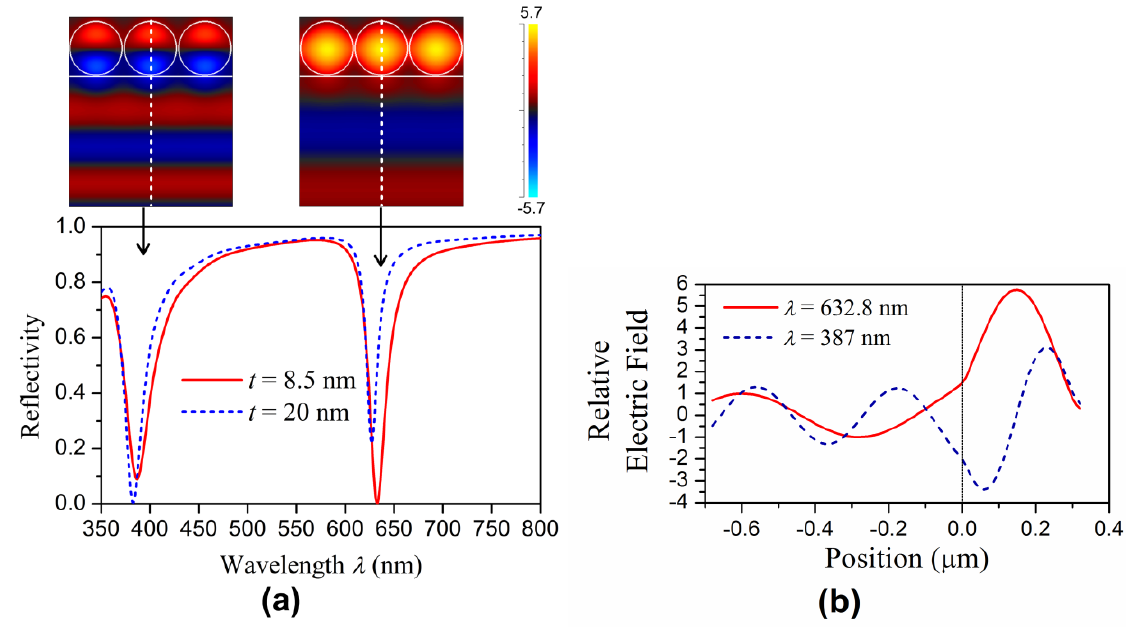
Figure 2. (a) Reflection spectrum for the normal incident light. The two insets show the relative electric field distributions for the two spectral dips, respectively. (b) Relative electric field distributions along the y axis (the dashed cross-section lines shown in the insets) for the two spectral dips with t = 8.5